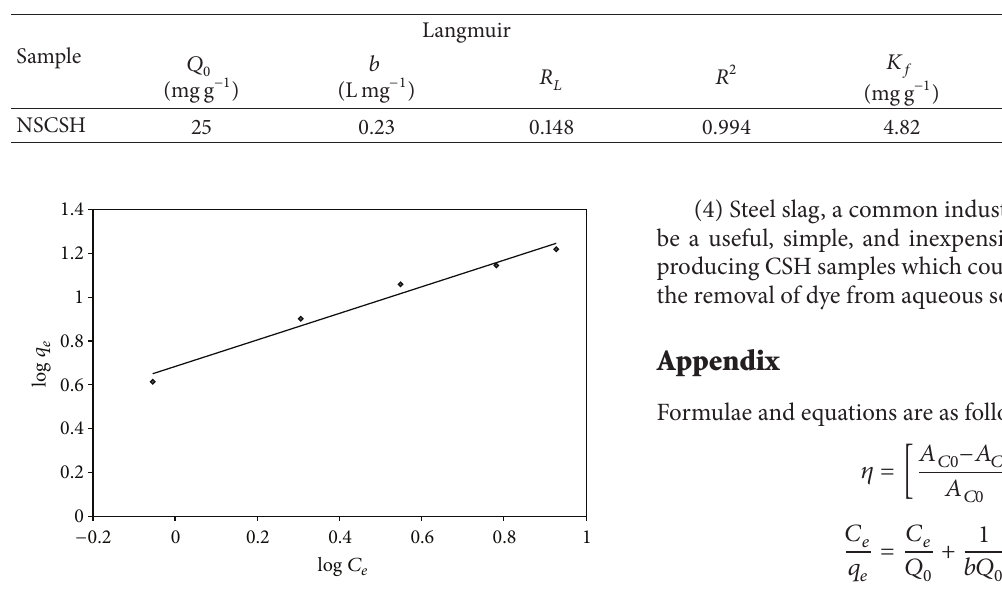
Figure 8: Freundlich adsorption isotherm for RhB onto NSCSH.